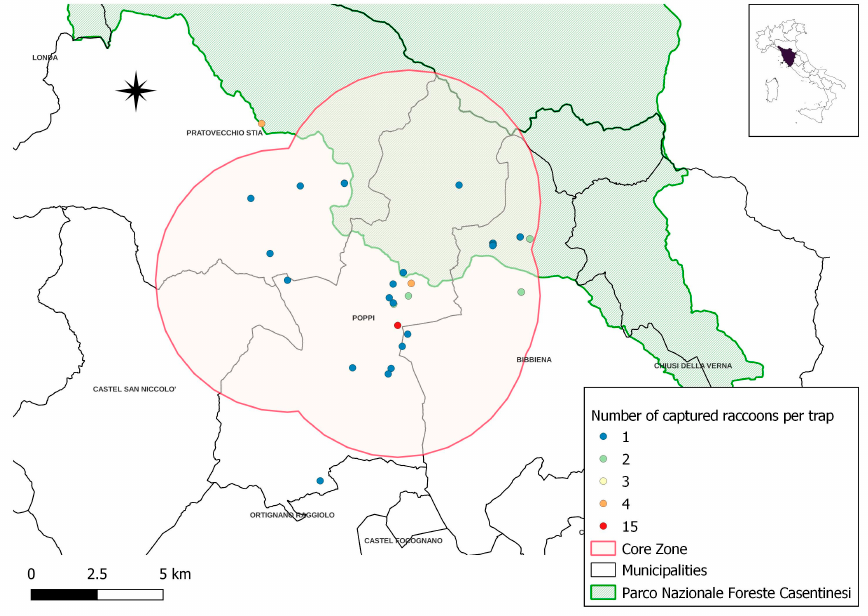
Figure 2. Raccoon-trapping sites (the proximity of some trapping sites results in the overlapping of dots in the picture). The red areas represent the raccoon “core zone”. Table 4. Number of trapped raccoons in each trapping